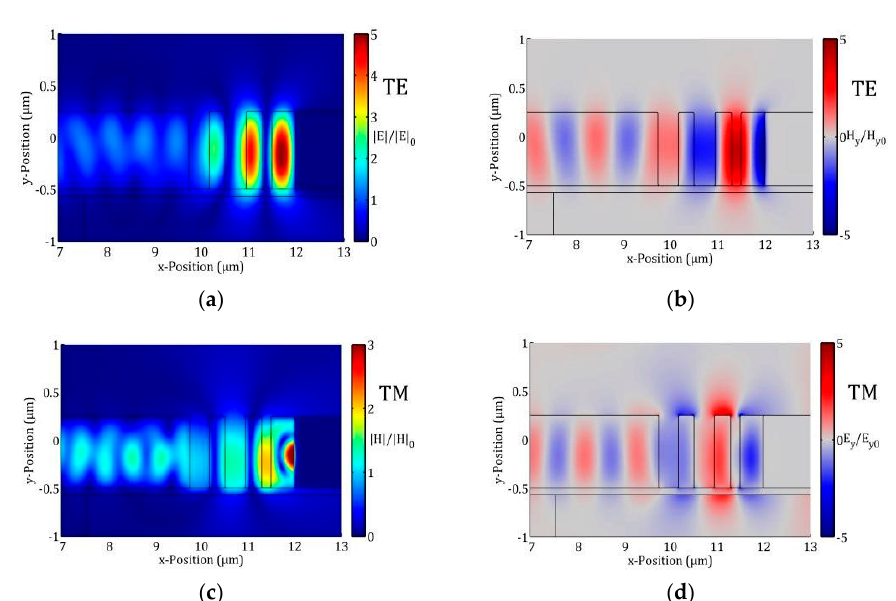
Figure 2. Resonance profile for the total electric field amplitude |(cid:1831)| ( a ) and the y-component of the magnetic field (cid:1834) (cid:1877) ( b ) (TE) and (cid:1875) = 1.5 µm. The correspondings fields (TM) of |(cid:1834)| and (cid:1831) (cid:1877) are shown in ( c , d ). |(cid:1831)| 0 , 0 ,|(cid:1834)| 0 ,(cid:1831) (cid:1877)0 denote the incident wave field